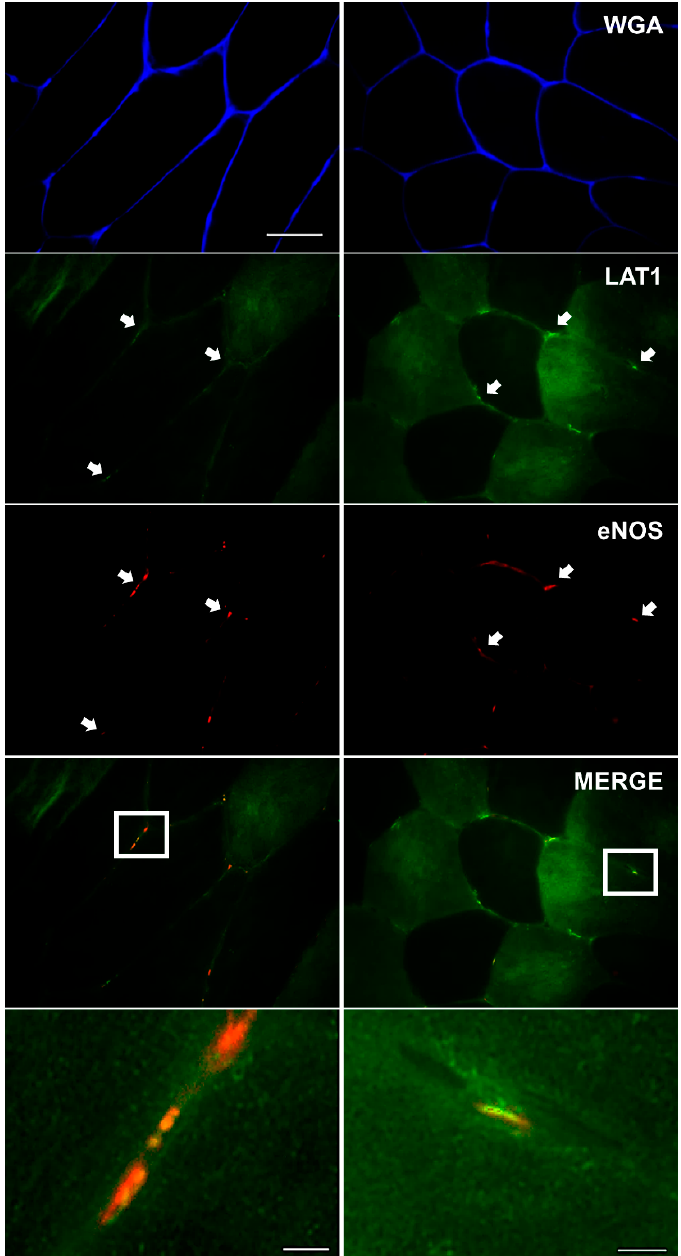
Figure 4. Immunofluorescent detection of LAT1 in human vastus lateralis muscle co-stained with endothelial nitric oxide synthase (eNOS) and Wheat Germ Agglutinin (WGA). Sections were stained with anti-LAT1 antibody (green) and then co-stained with eNOS (red) for the identification of blood vessels. WGA (blue) was used to identify membrane borders. Representative images from two participants are displayed. Merged images display positive LAT1 staining localising close to positive eNOS staining, shown in greater detail in zoomed images (bottom panels). Scale bar in top left panel is 50 μ m and all images (except zoomed images) were captured at the same magnification. Scale bar in bottom panels is 5 μ m.